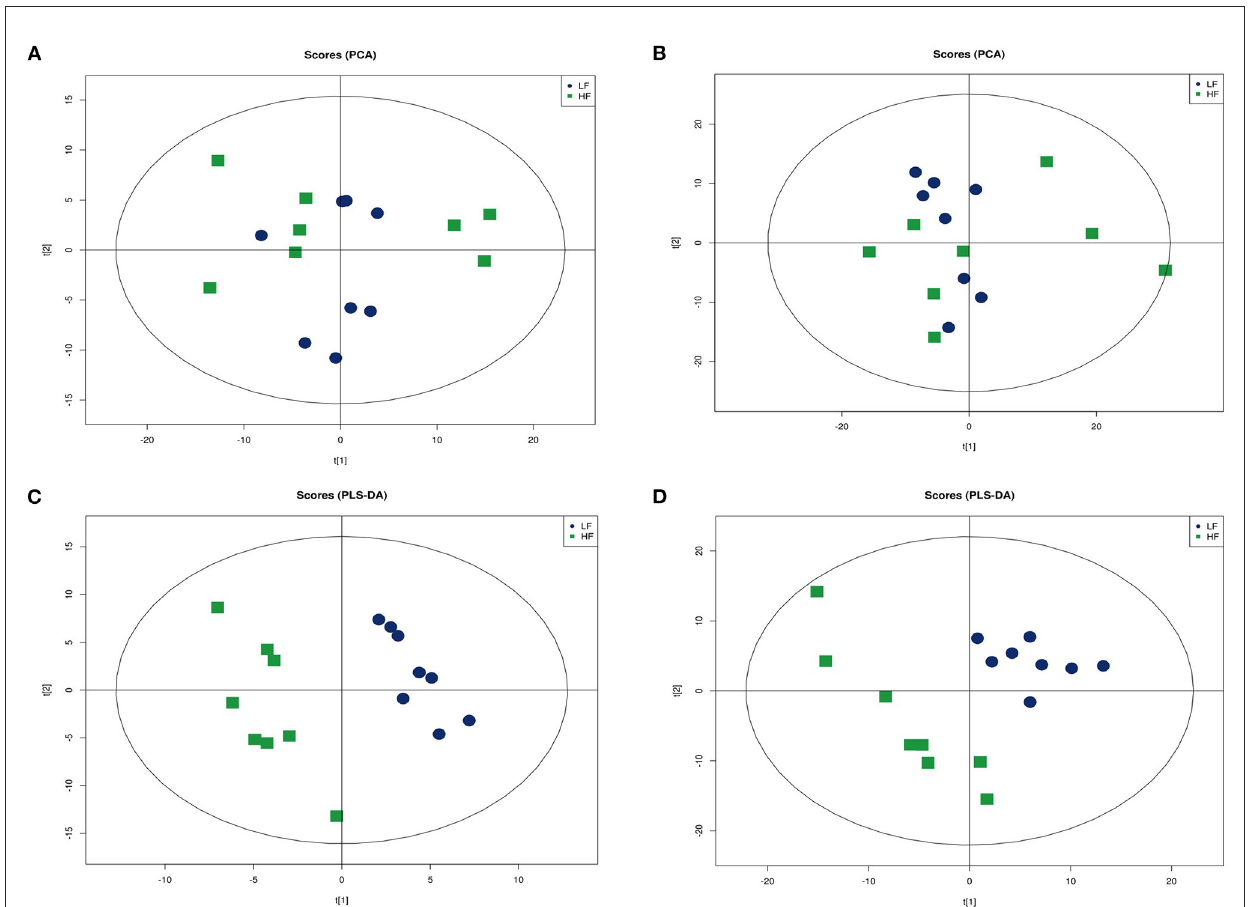
FIGURE3 Multivariate statistical analysis of seminal plasma metabolic profiling of the HF and LF groups. (A) Principal component analysis (PCA) score plots in the positive ion mode. (B) PCA score plots in the negative ion mode. (C) Partial least squares-discriminant analysis (PLS-DA) score plot in the positive ion mode. (D) PLS-DA score plot in the negative ion